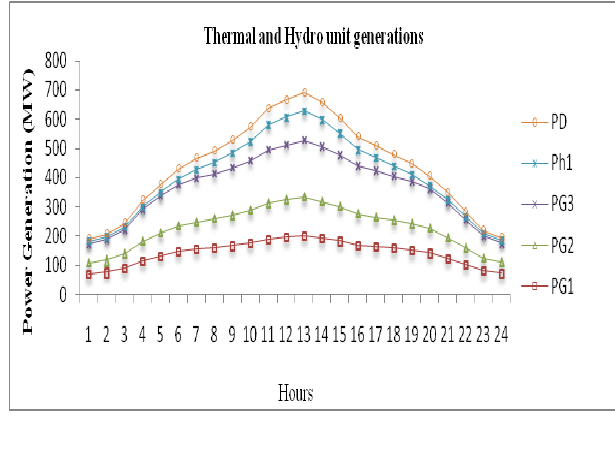
Figure 2. Unit wise Generation Table 4. Power loss obtained from AL